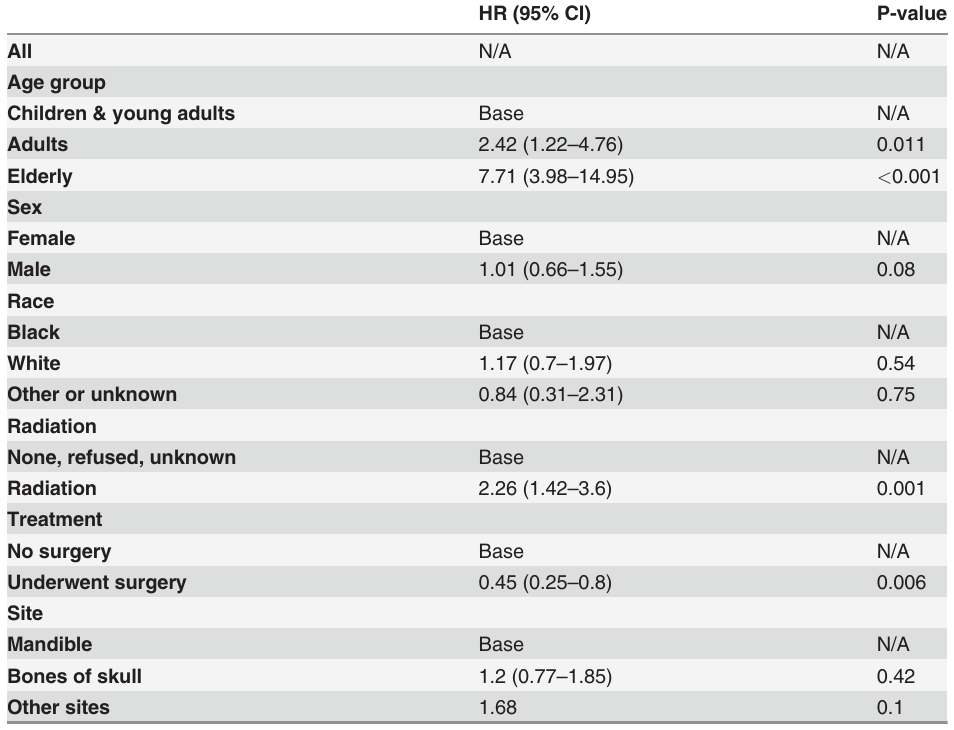
Table 4. Overall survival.